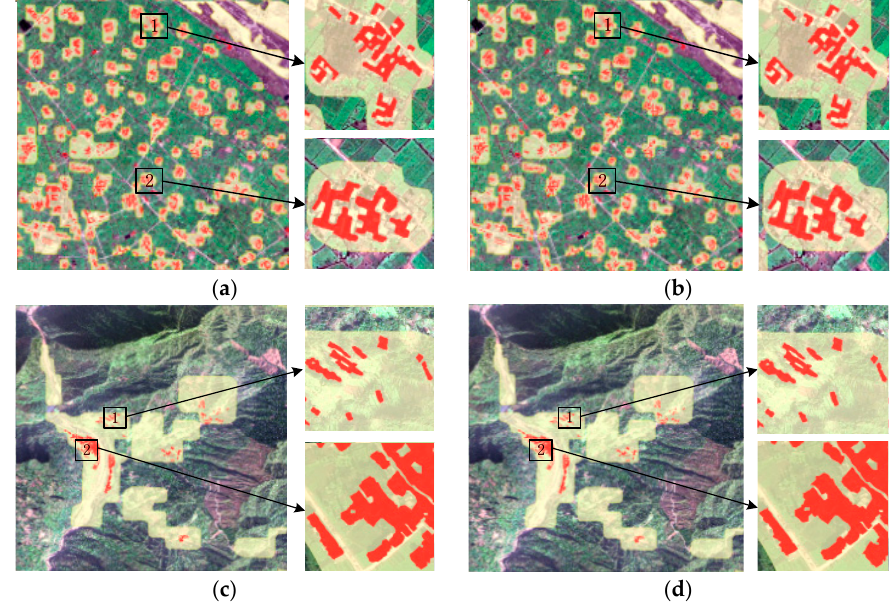
Figure 11. Building results of the “generalized-image” comparison experiments: ( a ) only QuickBird image; ( b ) “generalized images” (for QuickBird image); ( c ) only Pléiades image; and ( d ) “generalized images” (for Pléiades image). Table 4. Quantitative evaluation of the building results of the different methods